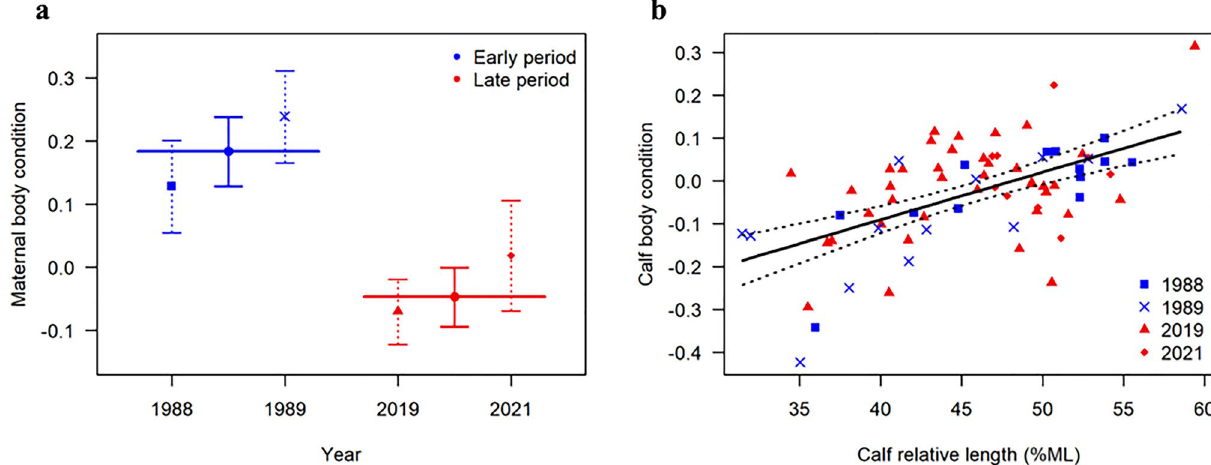
Figure 3. ( a ) Effects of year and period (see colour key) on maternal body condition in South Africa’s southern right whales. The points show the predicted mean body condition values from the best-fitting model for year (Model 3 in Table 2) and period (Model 2 in Table 2). The error bars show the 95% confidence intervals. ( b ) Calf body condition as a function of calf relative body length (% of maternal length, ML). The solid black line shows the predicted mean values of the best-fitting model (Model 4 in Table 3). The dotted black lines show the 95% confidence